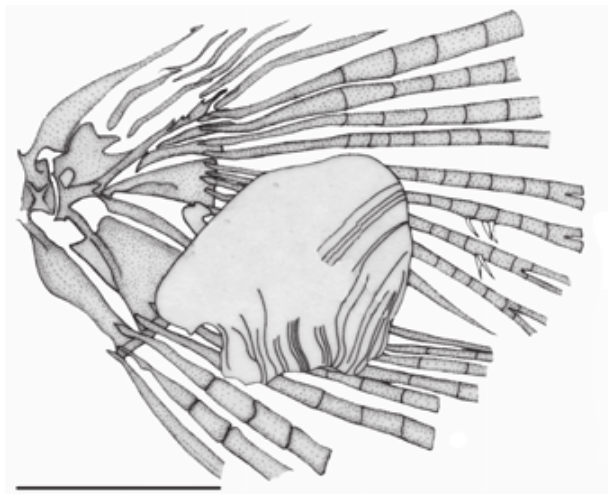
Fig. 6. Tyttocharax metae , paratype, IUQ 2343, adult male, 18.4 mm SL. Caudal skeleton view, left lateral view, pouch scale. Scale bar = 1 mm.